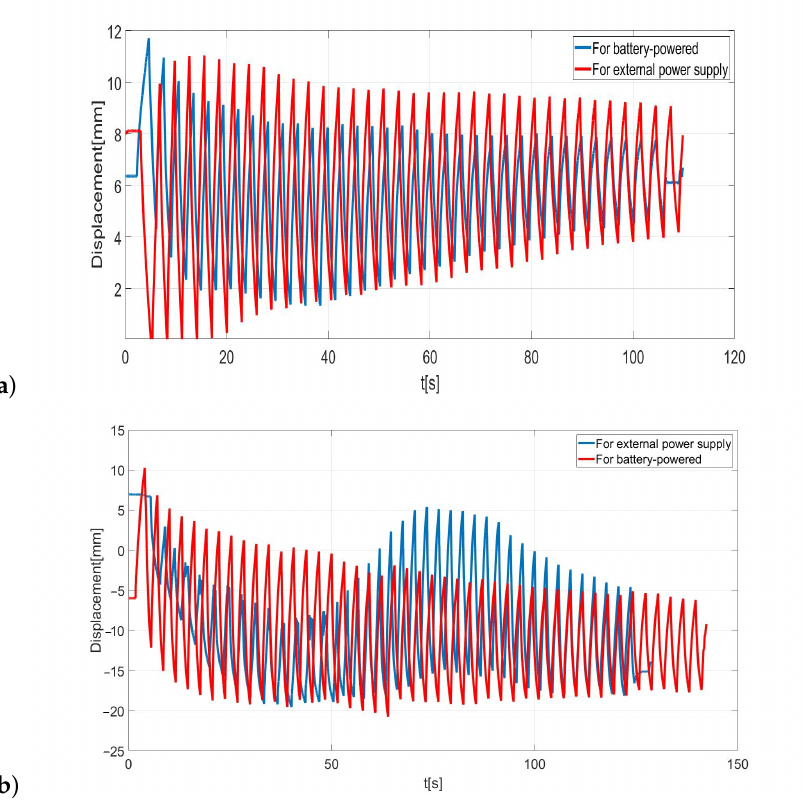
Figure 5. Displacement values determined by computer method for sample 1 ( a ) and for sample 2 ( b ).